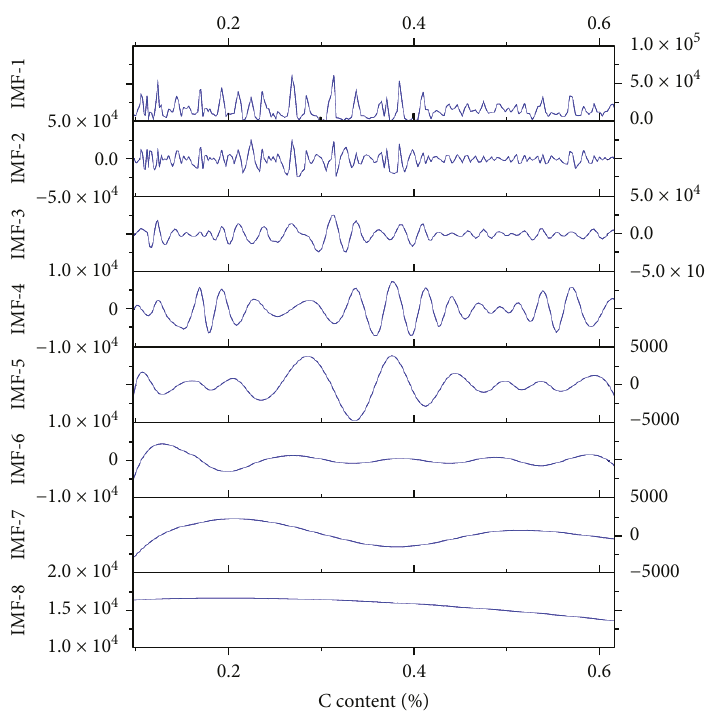
Figure 9: Carbon-IMF frequency diagram of converter 6C00582 signalled with absolute intensity.